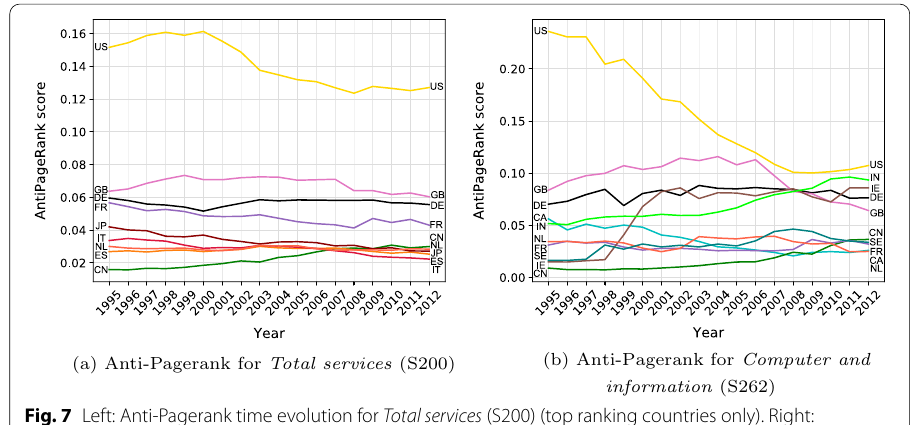
Fig. 7 Left: Anti-Pagerank time evolution for Total services (S200) (top ranking countries only). Right: Anti-Pagerank time evolution for Computer and information (S262) (top ranking countries